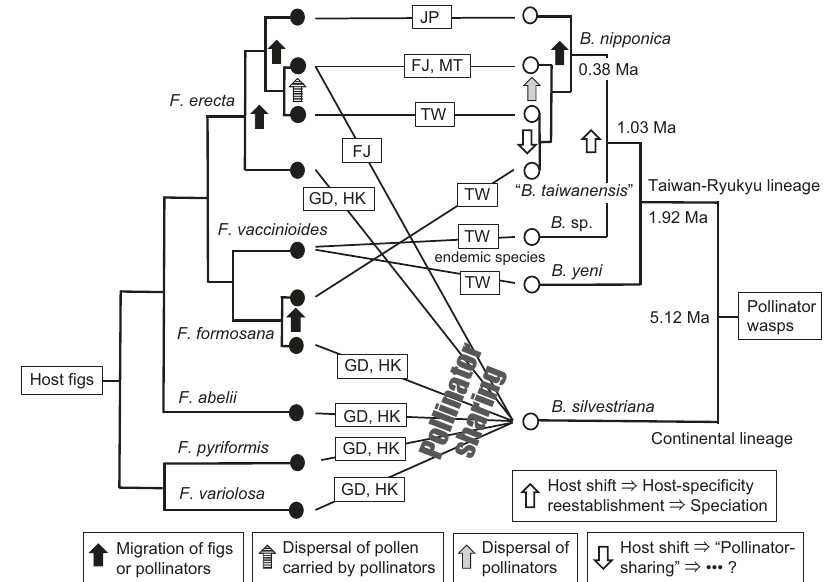
Fig. 5 Summary of phylogenetic relationships of fi gs and their pollinator wasps. The fi g tree topology is based on the results obtained from MIG-seq and SSR data (Figs. 2 and 4a), while that of pollinators is based on the results inferred from COI - COII sequences and SSR data (Figs. 3 and 4d). The possible evolutionary events, including migrations of fi gs and pollinators, pollen and wasp dispersal, and host shifting are indicated (for host shifting events, see Supplementary Fig. 12b). Solid circles and open circles show fi gs and pollinators, respectively. The divergence times between pollinator lineages are from the results of the dating analysis (Supplementary Fig. 10). JP Japan, FJ Fujian, MT Matsu Islands, TW Taiwan, GD Guangdong, HK Hong